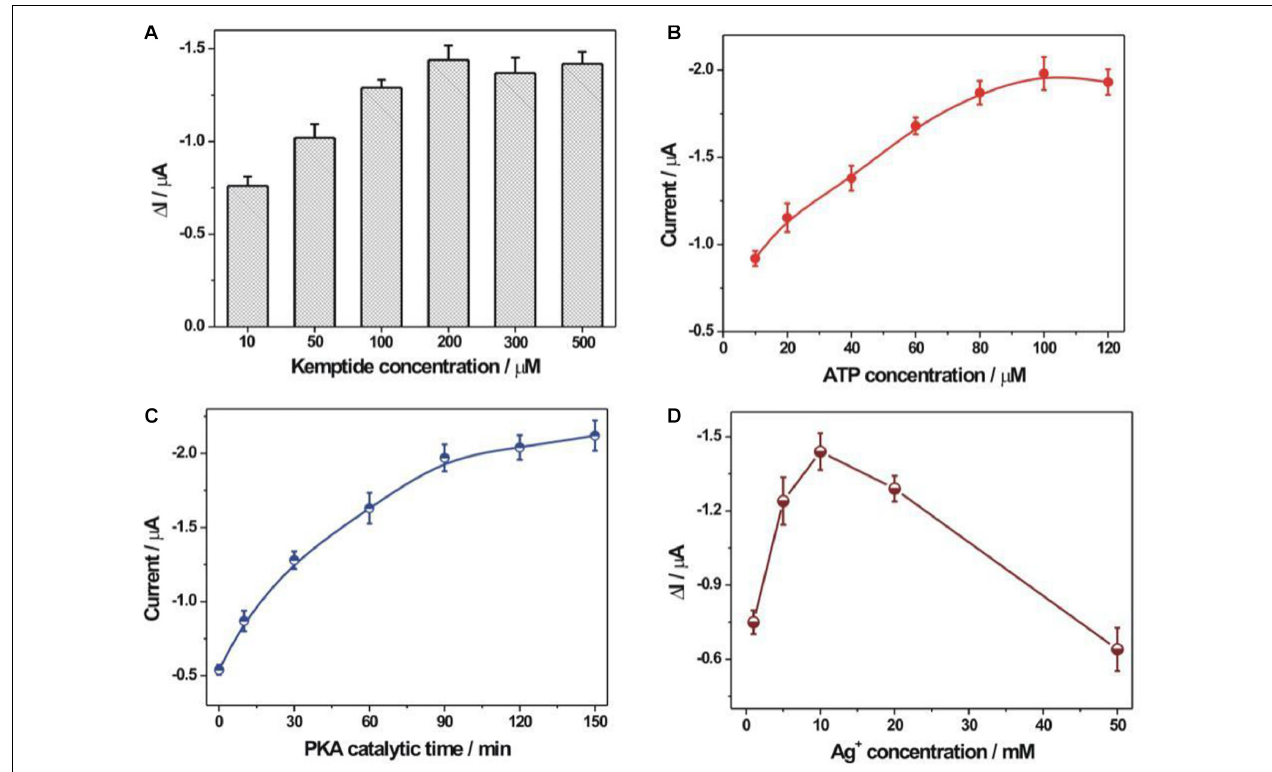
FIGURE 4 | Optimization of experimental conditions. (A) The immobilization concentration of kemptide. Various kemptide concentrations (10, 50, 100, 200, 300, and 500 µ M) were applied. (B) ATP concentration optimization. A series of ATP concentrations including 10, 20, 40, 60, 80, 100, and 120 µ M were used. (C) The optimization of PKA catalytic time. The employed PKA catalytic time was 0, 10, 30, 60, 90, 120, and 150 min, respectively. (D) The optimization of AgNO 3 concentration during the synthesis of rGO-PDA-AgNPs nanocomposite. Various AgNO 3 concentration (1, 5, 10, 20, and 50 mM) were studied. The error bars were based on at least three repetitive experiment results. The used PKA concentration was 10